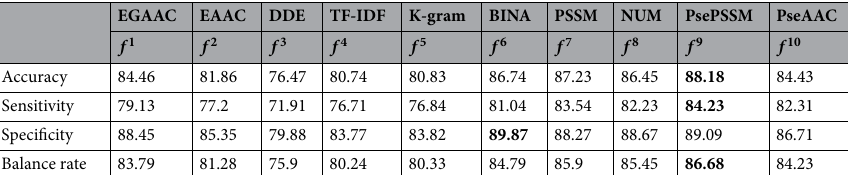
Table 3. System efficiency criteria for different features. Significant values are in bold.